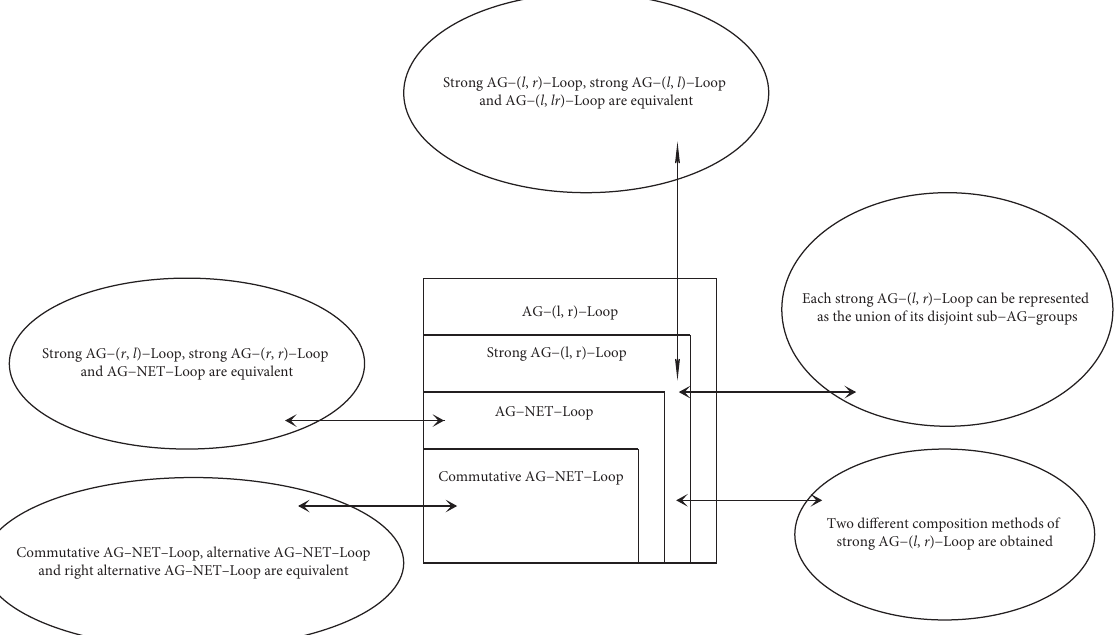
Figure 5: The main results of this